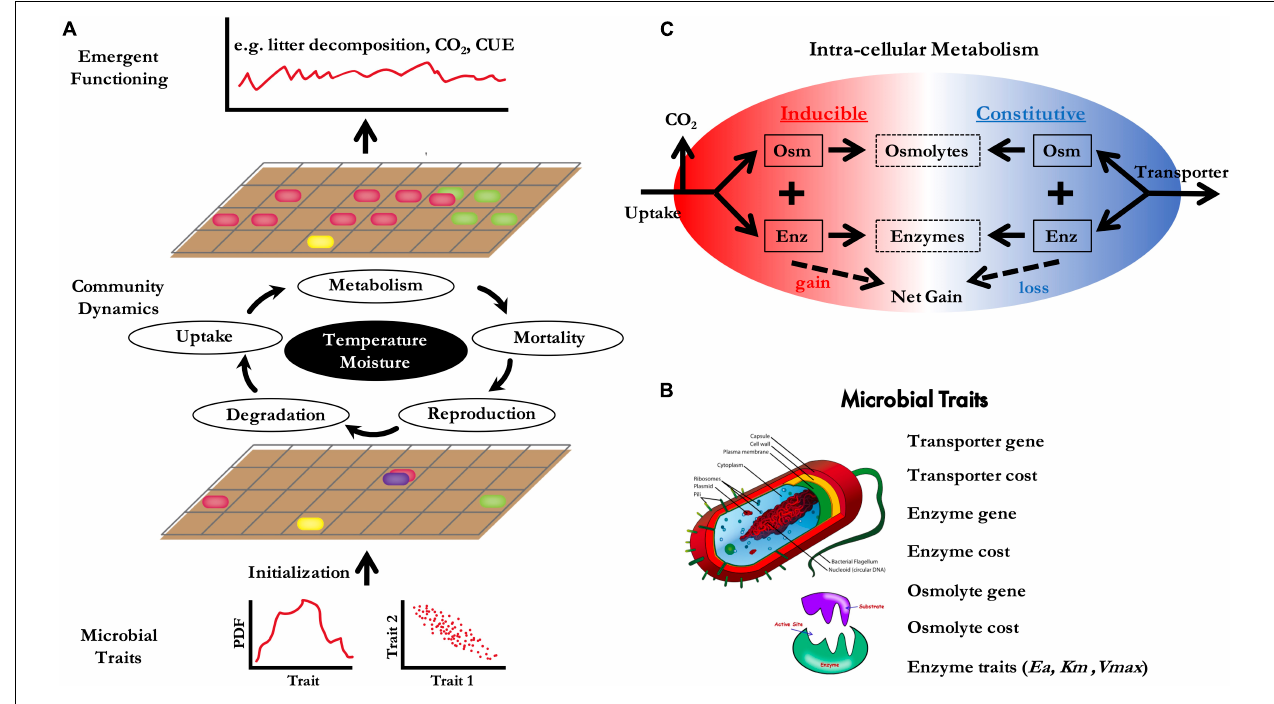
FIGURE 1 | Schematic of the DEMENTpy model. DEMENTpy bridges across microbial traits, community-level processes, and system-level functions (A) . Major traits include gene richness and production rate for transporters, enzymes, and osmolytes, as well as enzyme kinetic parameters (B) . These traits dictate cellular level metabolic processes of constitutive and inducible production of enzymes and osmolytes (C)